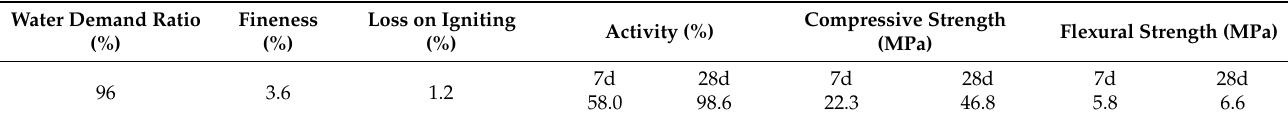
Figure 1. The three mineral admixtures used in the experiment. Table 2. Physical properties of the fly ash.